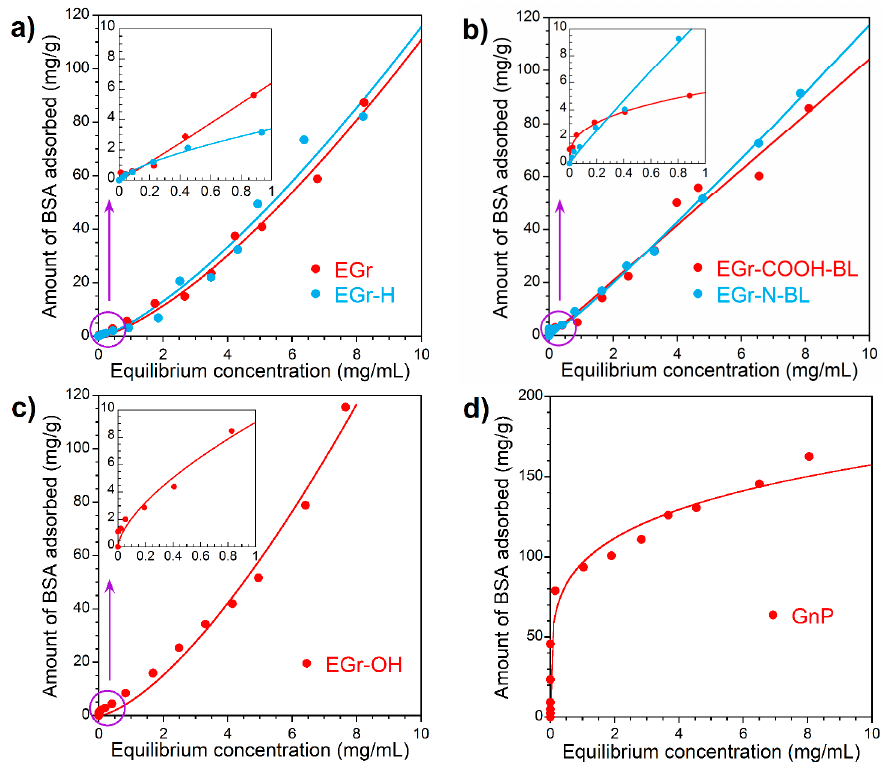
Figure 6. BSA adsorption isotherms: ( a ) on as-received (EGr) and heated at 900 °C (EGr-H); ( b ) carboxylated (EGr-COOH, bottom layer) and aminated (EGr-N, bottom layer); ( c ) hydroxylated (EGr-OH) expanded graphite’s and ( d ) on the graphene nanoplatelets (as-received GnP) in the range of concentration (0.025–10.0 mg/mL) (Inside of the Figure: BSA adsorption isotherm in the range of concentration 0.025–1.0 mg/mL). The equilibrium data was fitted using the Freundlich model.